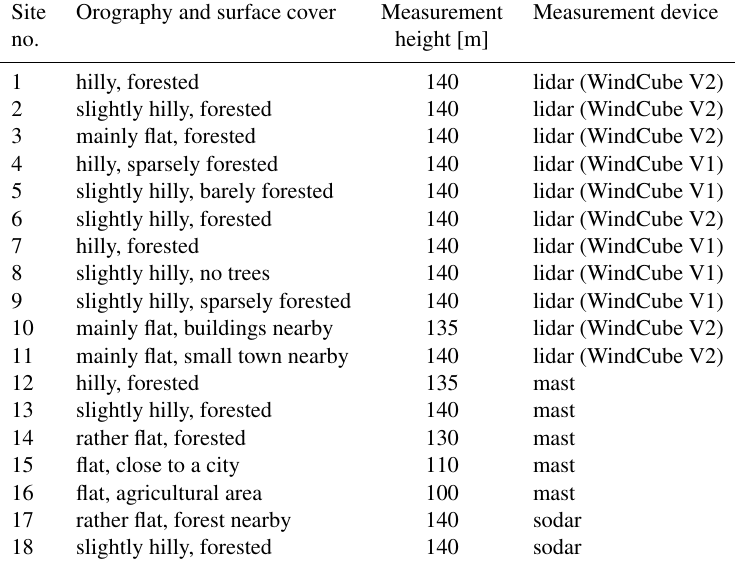
Table 1. Details of the measurement sites. The duration of the individual measurements is exactly 1 year. The measurements were carried out between May 2013 and April